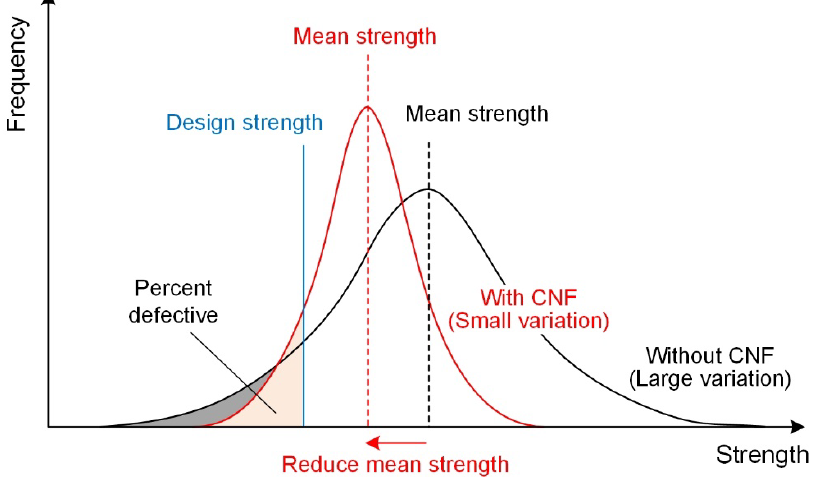
Figure 10. Conceptual diagram of frequency distribution of strength and design strength.